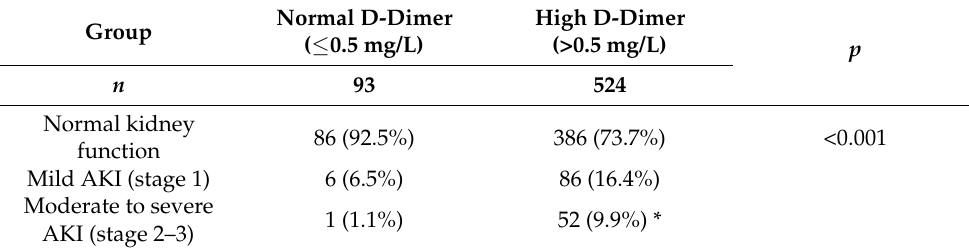
Table 4. Comparison of the prevalence of AKI stages between the normal and high D-dimer groups.